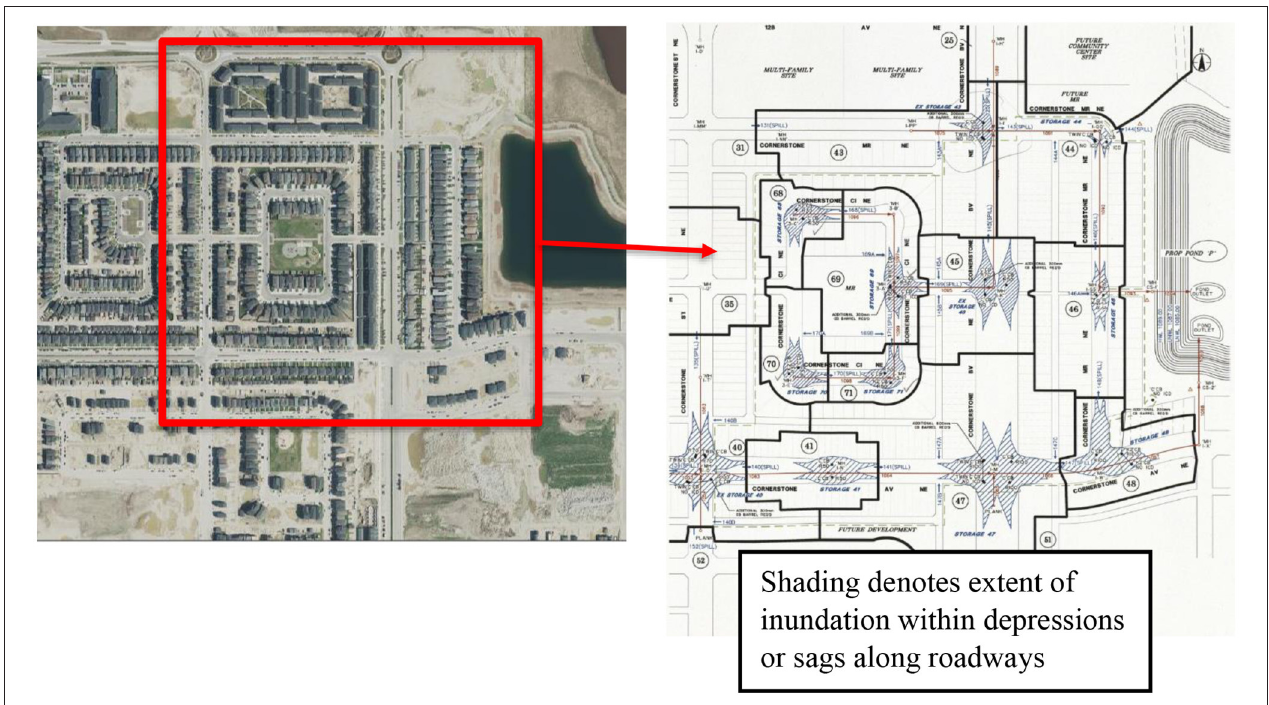
FIGURE 4 | Sample Community used for Stress Test Analysis.